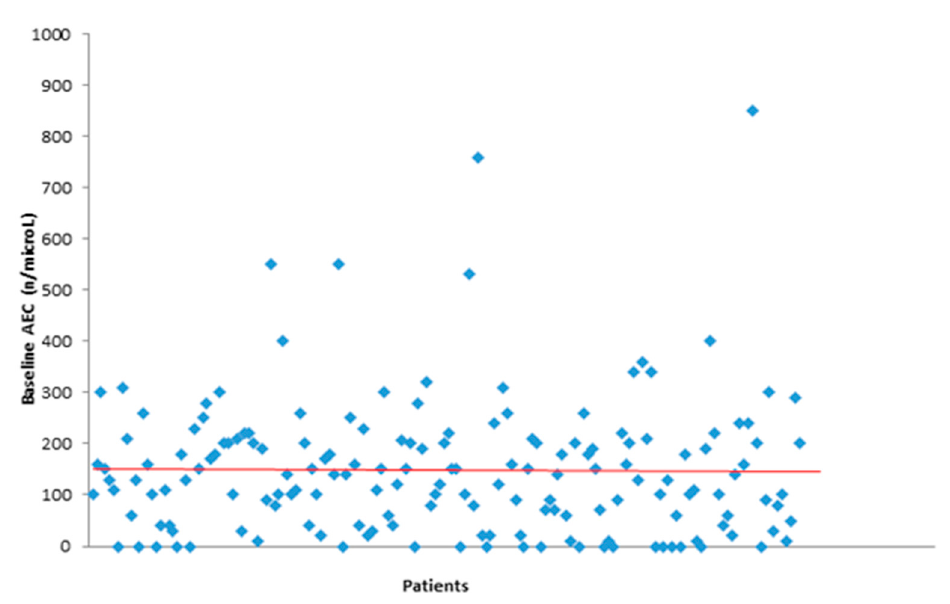
Figure 1. Baseline absolute eosinophil count (AEC). Table 3. Basal AEC in patients with irAEs and without irAEs.